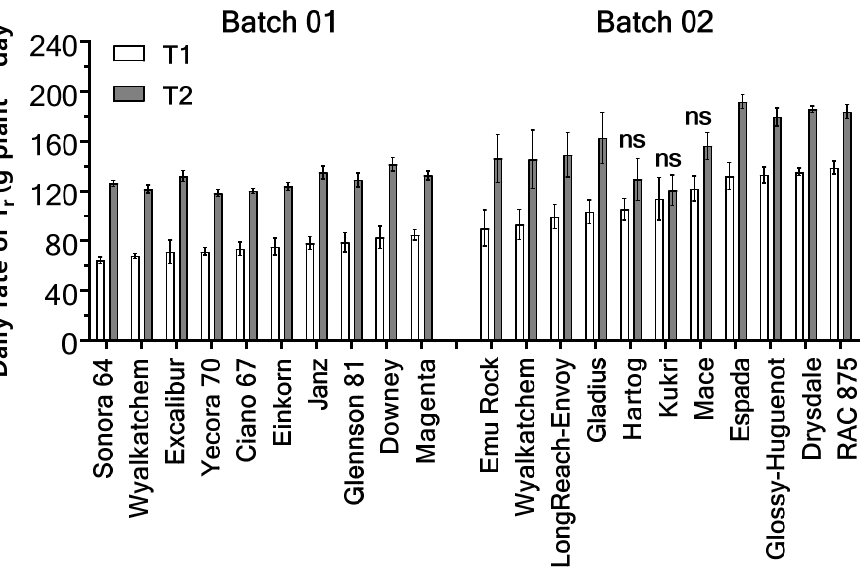
Figure 1. Mean daily rate of transpiration (T r ) of 20 wheat genotypes in Batch 01 and 02 under ambient (T1) and high (T2) temperature regimes over the period of temperature treatment. Mean daily rate of T r was calculated by dividing total water use per plant over the treatment period by the duration of the temperature treatment. Error bars indicate ± SEM; n = 4. The letters “ns” indicate no significant difference ( p > 0.05) in the average daily rate of T r between the two temperature